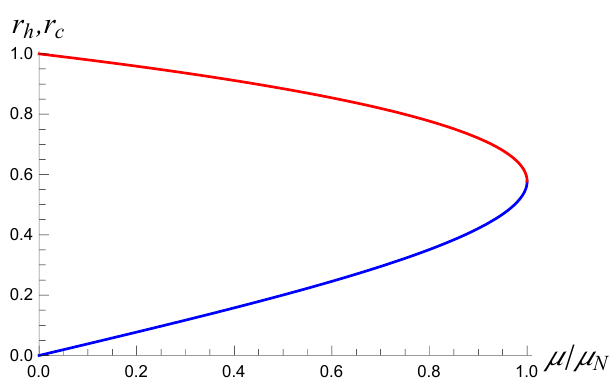
Figure 5 . Plot of the horizon radii r h (blue) and r c (red) as a function of µ/µ N . The black hole horizon becomes larger as µ grows, while the cosmological horizon